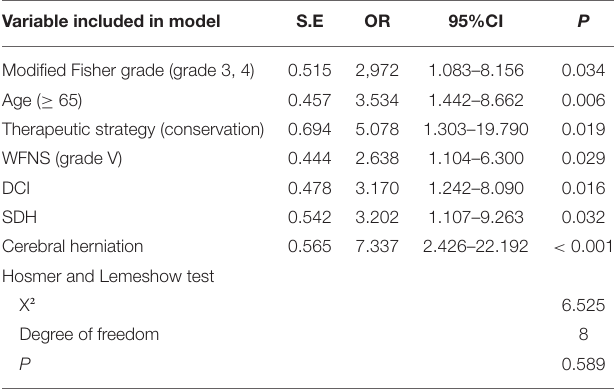
TABLE 2 | Multivariate logistic regression model for poor prognosis risk of poor-grade aSAH. Variable included in model